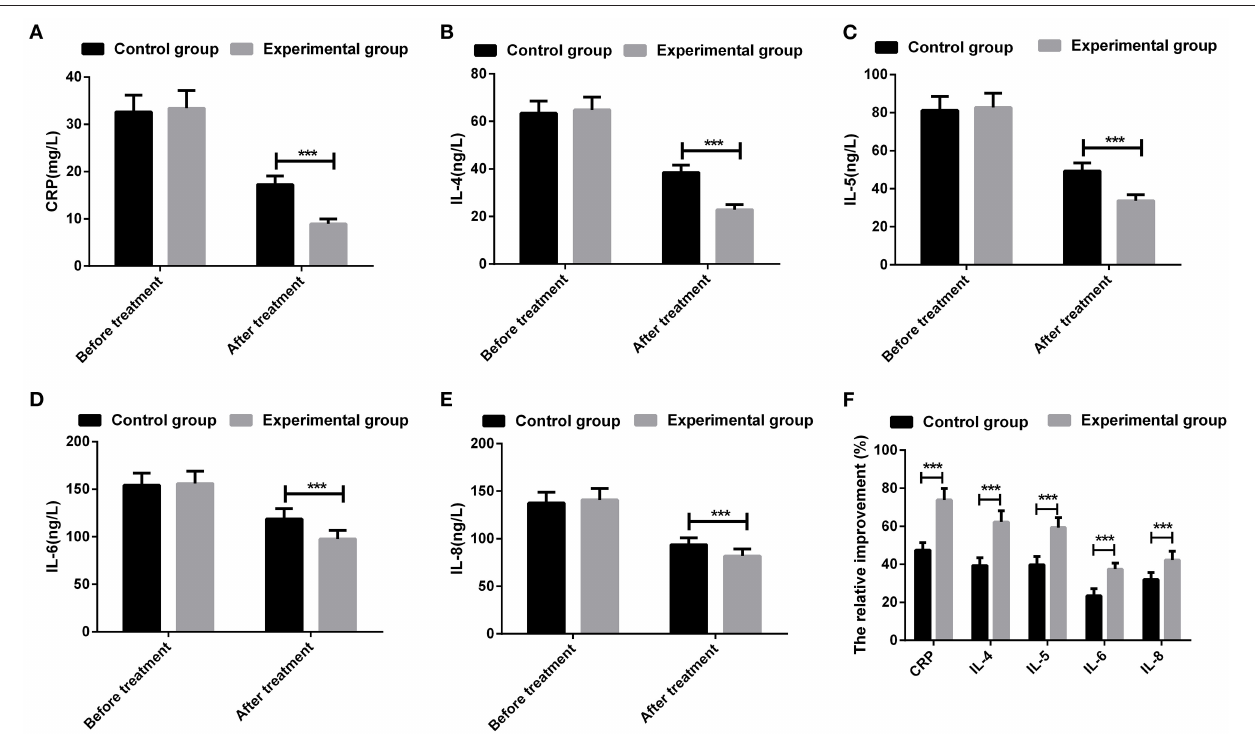
FIGURE 1 | Comparison of inflammatory cytokines of patients between the two groups. (A) serum level of C-reactive protein (CRP); (B) serum level of interleukin (IL)-4; (C) serum level of IL-5; (D) serum level of IL-6; (E) serum level of IL-8; (F) The relative changes of inflammatory cytokines in each group. *** P < 0.001; the measurement data were expressed as mean ± SD and analyzed using a t -test.